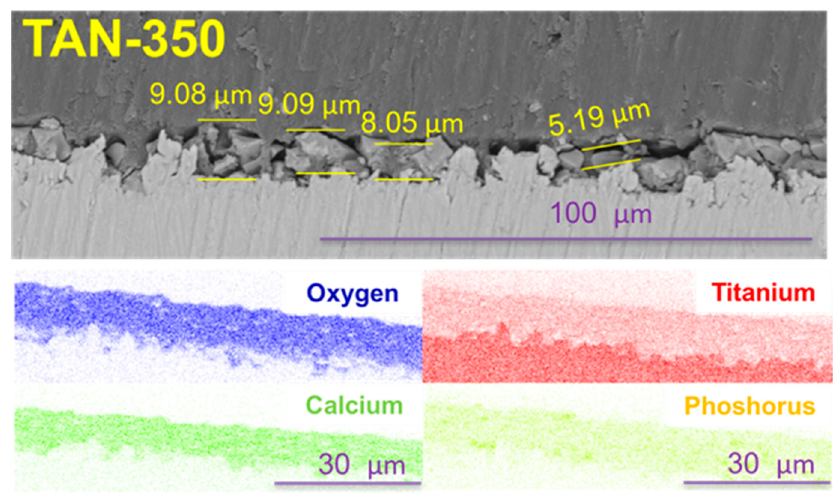
Figure 3. Cross sections of: TAN-350 and EDX mapping of selected part of oxide layer.